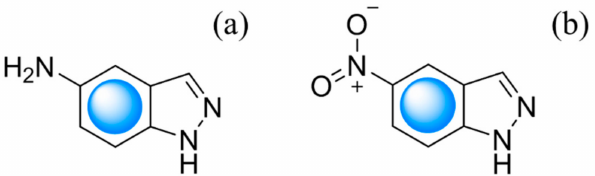
Figure 1. Molecular structures of indazole derivatives, ( a ) 5-aminoindazole; ( b )